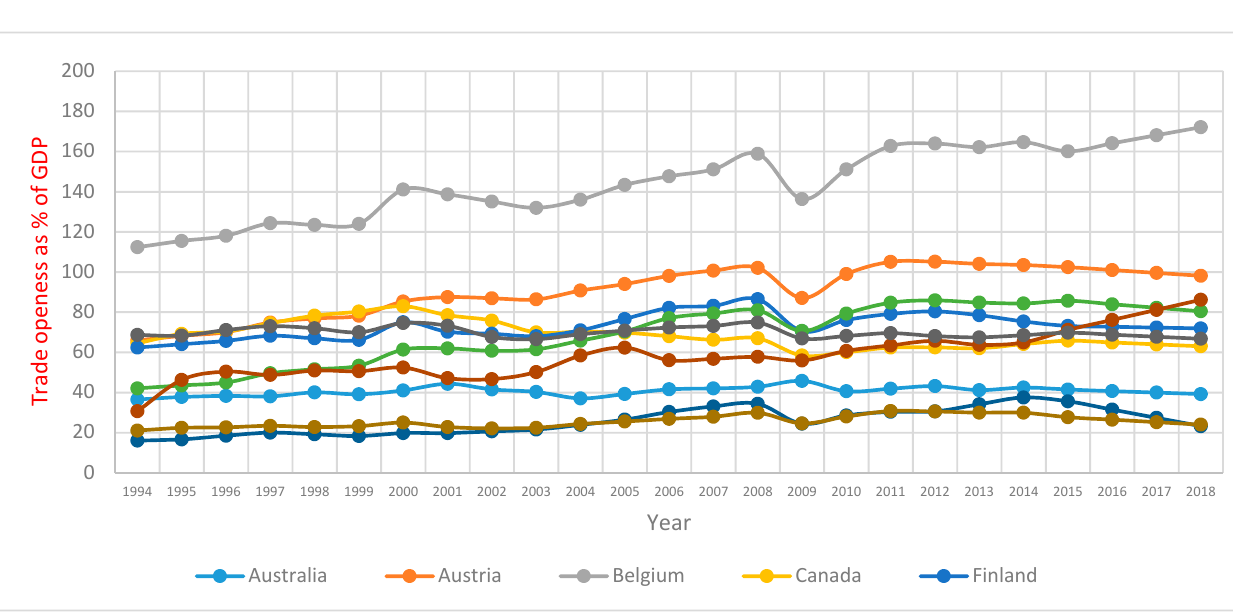
Figure A3. Ten OECD countries’ trade openness (%).